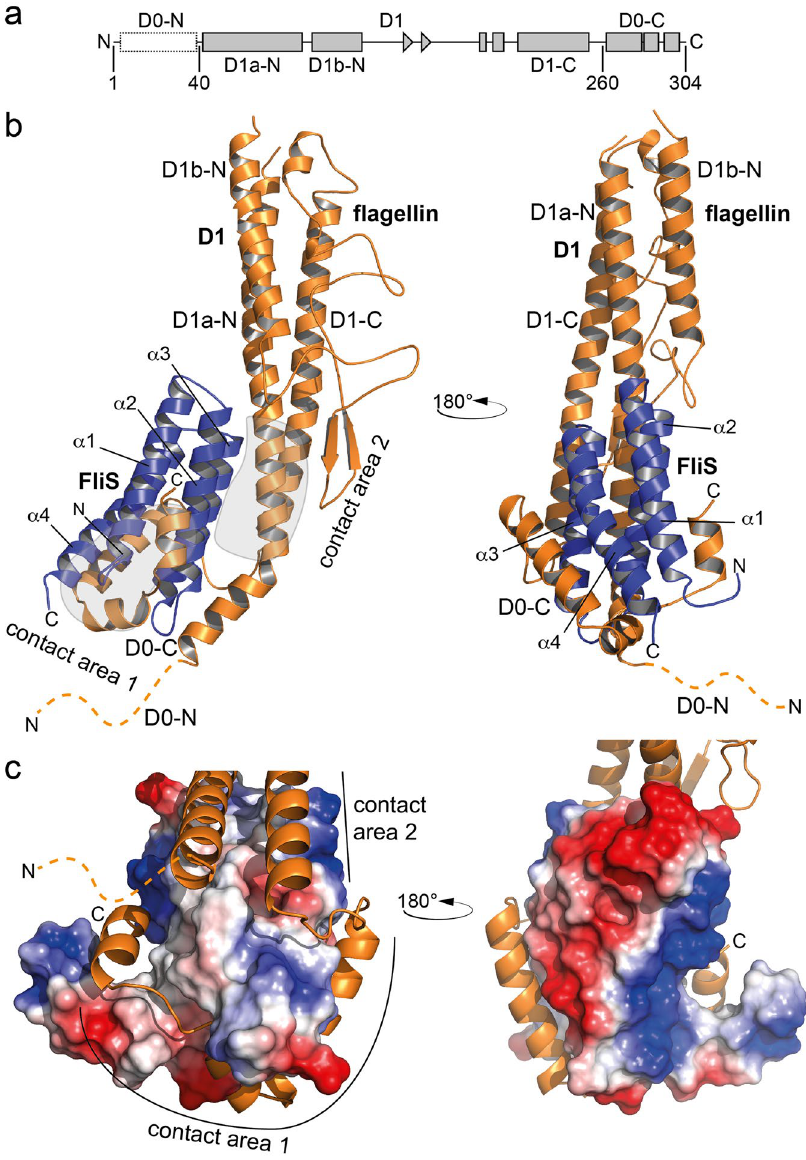
Figure 1. Crystal structure of the flagellin/FliS heterodimer. ( a ) Domain organization of flagellin. ( b ) Crystal structure of flagellin/FliS as a cartoon representation in two orientations. flagellin and FliS are shown in orange and blue, respectively. ‘N’ and ‘C’ indicate N- and C-termini, respectively. The disordered N-terminus of flagellin is shown as dashed line. Contact areas between flagellin and FliS are encircled in grey. ( c ) Electrostatic surface potential of FliS within the contact area of flagellin to FliS. The flagellin-binding pocket is of hydrophobic and polar nature ( left side ), whereas the opposite site of FliS is highly charged ( right side